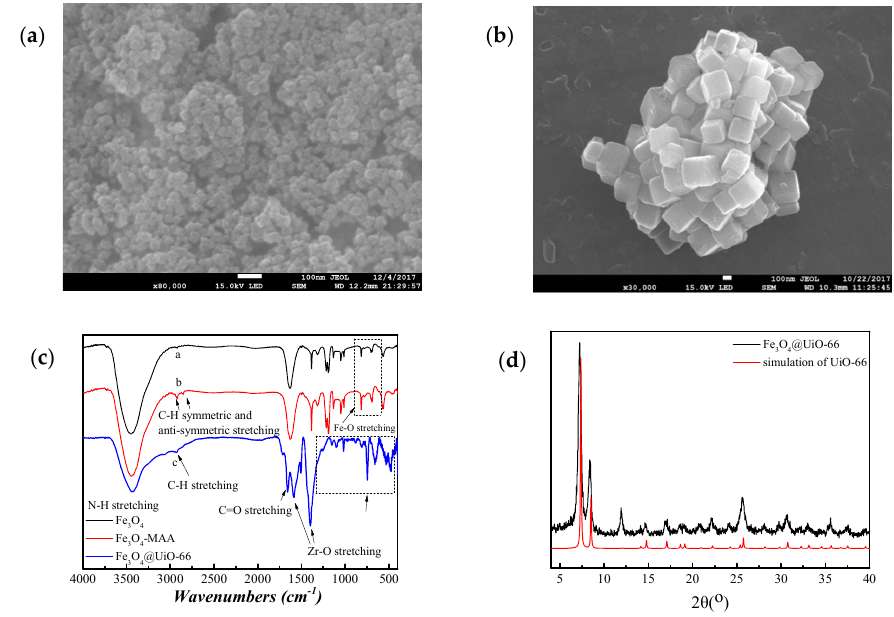
Figure 2. Field emission SEM image of ( a ) UiO-66 and ( b ) Fe 3 O 4 @UiO-66 composite, ( c ) FT-IR of Fe 3 O 4 , Fe 3 O 4 -MAA and Fe 3 O 4 @UiO-66, ( d ) PXRD patterns of Fe 3 O 4 @UiO-66 and simulation of UiO-66.